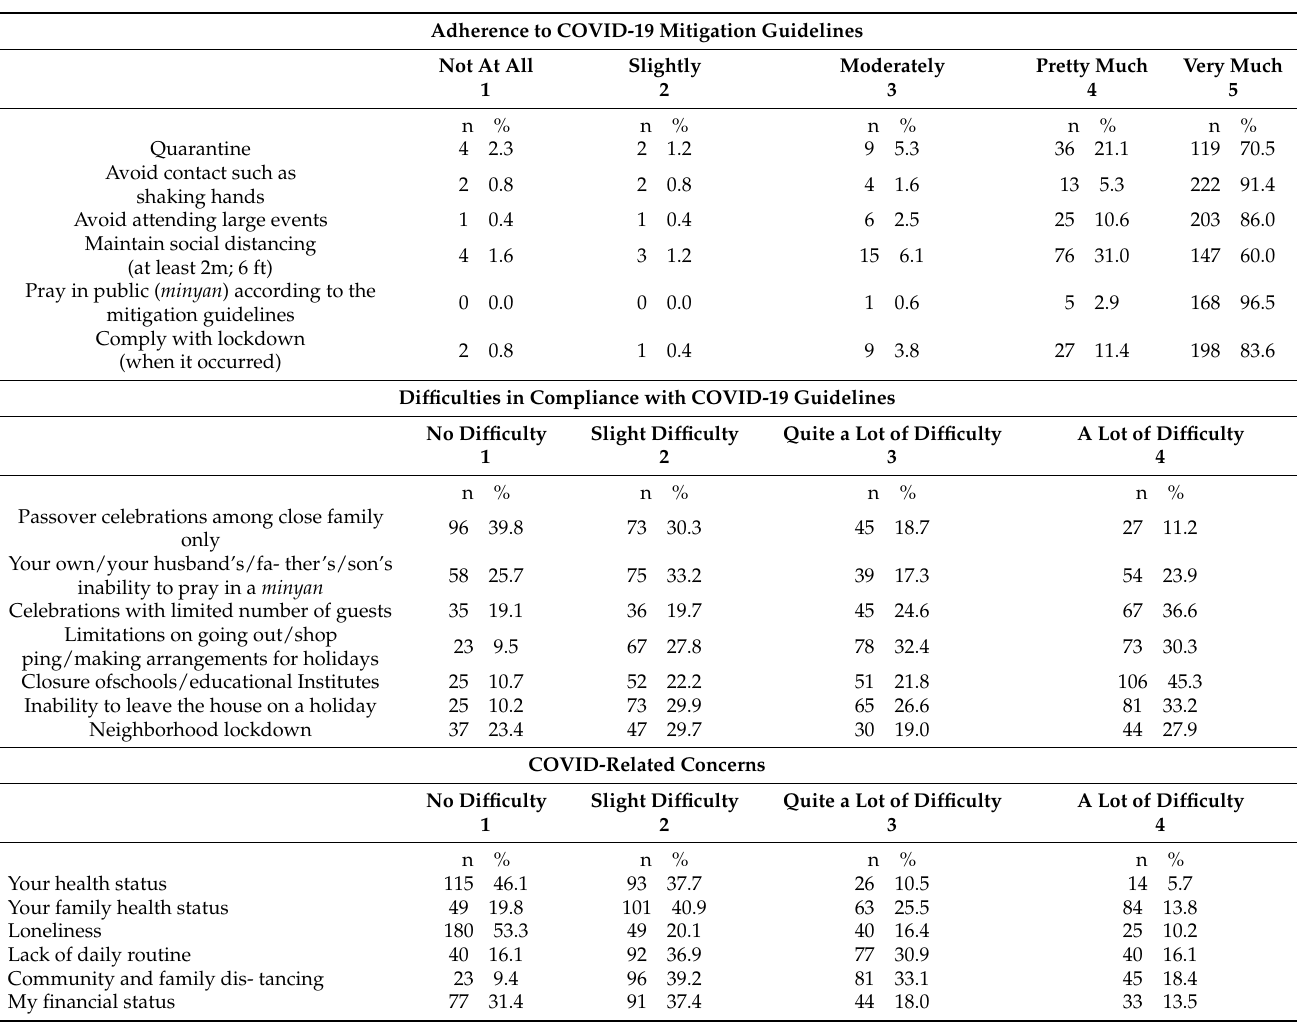
Table 1. Distribution of compliance with COVID-19 mitigation guidelines, difficulties in compliance with the guidelines, COVID-related concerns, and microaggression among Ultra-Orthodox Israelis (N = 225).